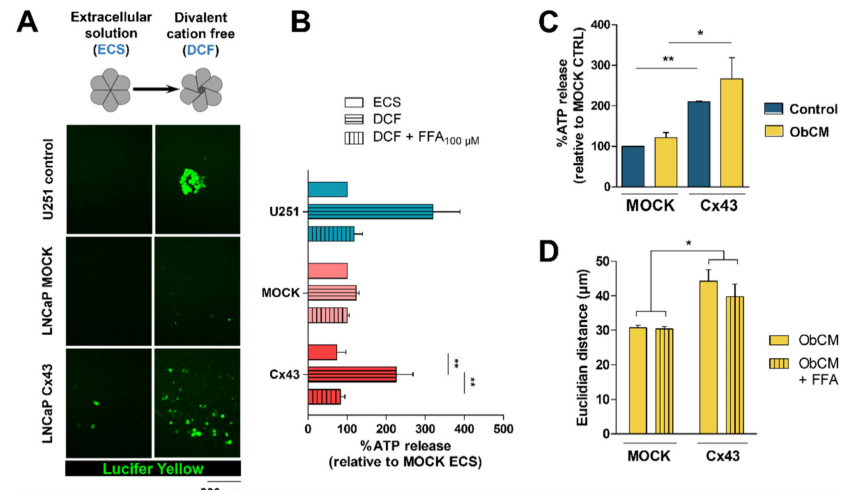
Figure 6. LNCaP Cx43 express functional hemichannels that do not contribute to ObCM induced migration. ( A ) Representative images of Lucifer Yellow incorporation assays performed with LNCaP cells. Cells were incubated in defined physiological solutions containing (ECS) or not divalent cations (DCF), allowing for the control of hemichannels opening. The hemichannel permeant dye tracer Lucifer Yellow (0.5 mg / mL) was added and uptaken by cells if hemichannel were functional. The glioblastoma cell line U251 expressing high levels of Cx43 and exhibiting high rates of Lucifer yellow (LY) uptake served as a positive control. ( B ) Biochemical assessment of hemichannel opening by means of ATP release quantification. The cells were treated as described in ( A ) with the addition of flufenamic acid (FFA 100 µ M), a hemichannel blocker. Cell supernatants were collected after 15 min and extracellular concentrations of ATP were determined by a luciferin-luciferase based assay. For each condition, luminescence values were normalized by total protein amount. Data represent the mean ± SEM from 3 di ff erent experiments, except for U251 ( n = 2). ( C ) Quantification of extracellular ATP after incubation of LNCaP cells with control media or ObCM. For each condition, luminescence values were normalized by total protein amount. Data represent the mean ± SEM from 3 di ff erent experiments. ( D ) quantitative analysis of single cell migration of LNCaP upon stimulation with ObCM with or without FFA (100 µ M). Data represent the mean ± SEM from 3 di ff erent experiments (ObCM-treated LNCaP MOCK n = 69; ObCM + FFA-treated LNCaP MOCK n = 65; ObCM-treated LNCaP Cx43 n = 76; ObCM + FFA-treated LNCaP Cx43 n = 55). * p < 0.05; ** p <